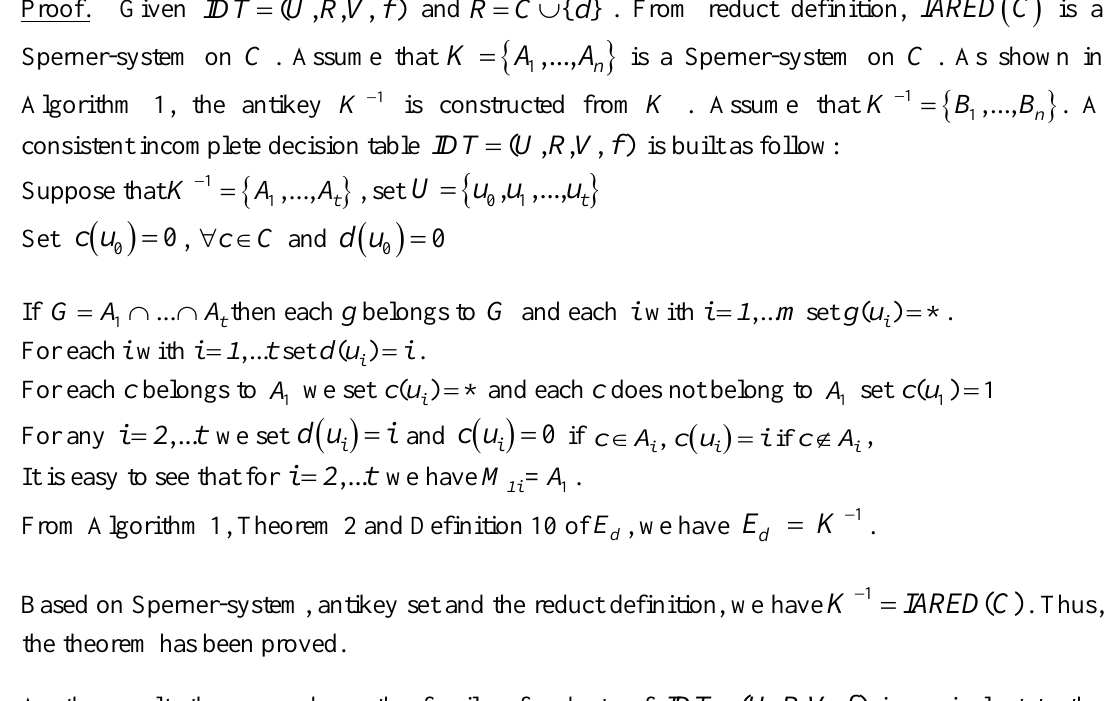
Algorithm 2. Constructing a CIDT from a given Sperner-system K over C . Figure 1 is the flowchart of Algorithm